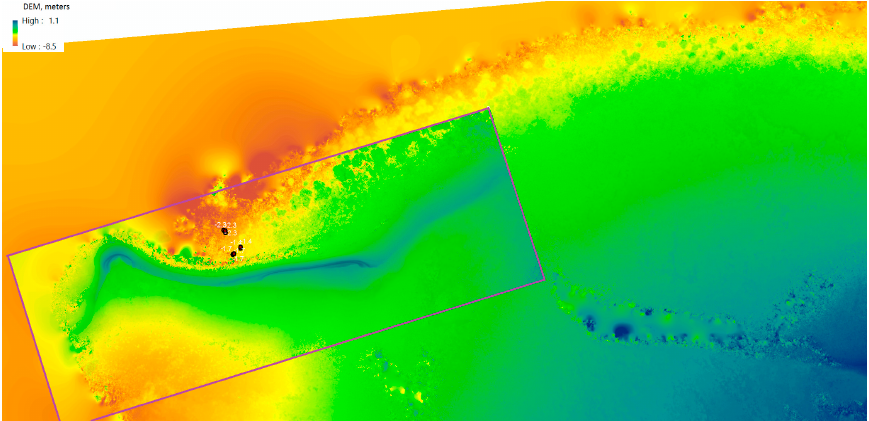
Figure 16. Digital elevation model (DEM) of Pandora Reef generated from Phantom 3 Pro and Canon 5DS R (purple area) and in-water survey depths (black dots).